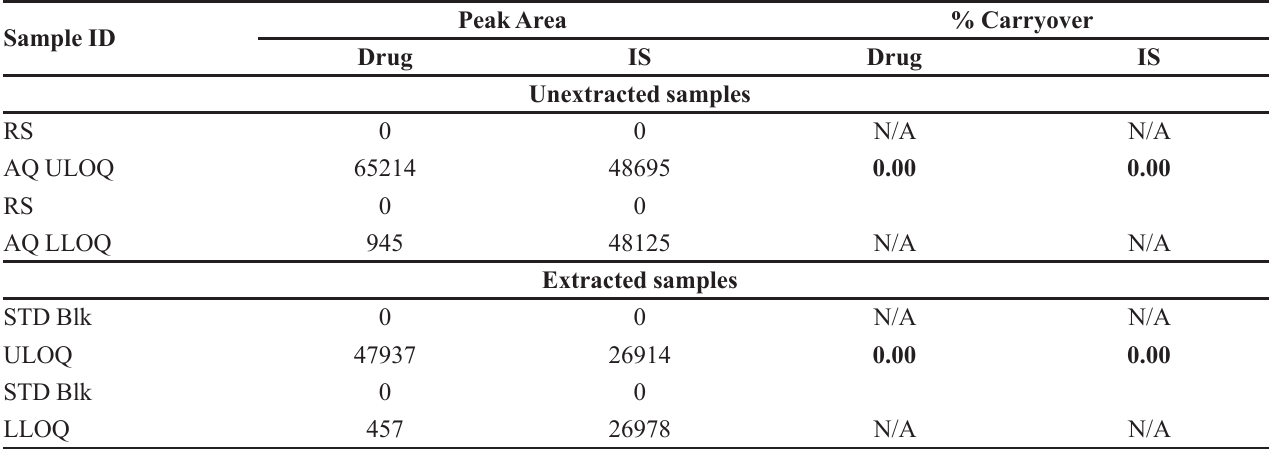
TABLE II - Auto sampler carryover Sample ID